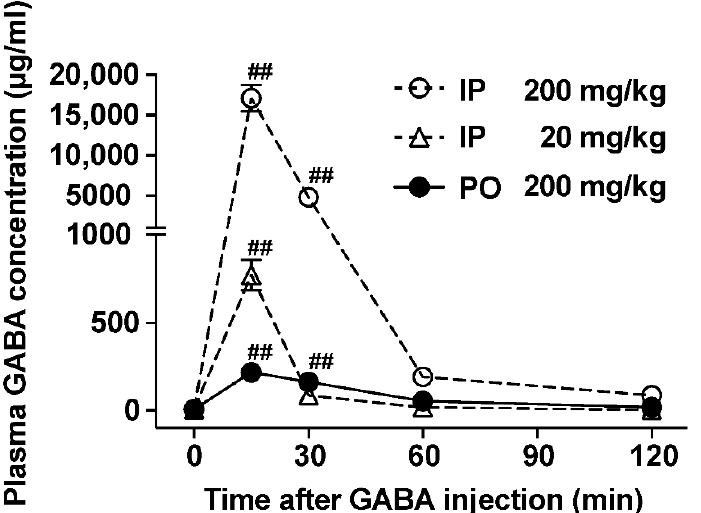
Figure 1. Plasma GABA concentrations in mice administered with peroral (po) vs. intraperitoneal (ip) GABA. Time course of GABA concentrations in the postcaval vein plasma after po administration of GABA (200 mg/kg; closed circle) or ip injection of GABA (200 mg/kg; open circle, 20 mg/kg; open triangle). n = 4–6. ## p < 0.01 by one-way ANOVA followed by Dunnett’s test vs. 0 min in each group. GABA: Gamma-aminobutyric acid.